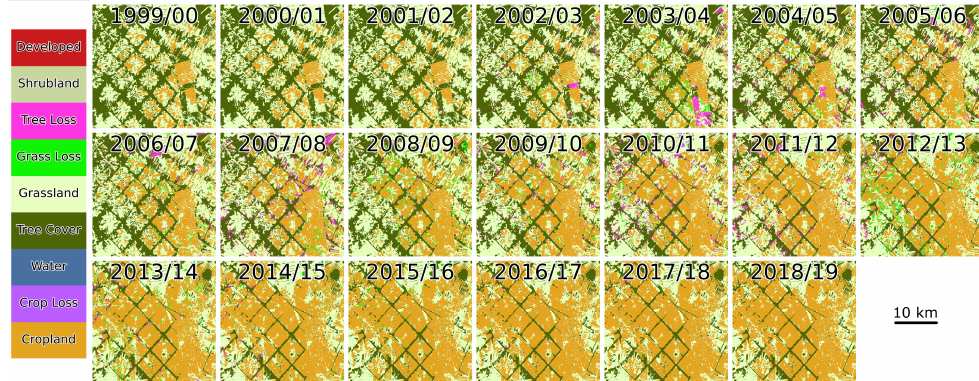
Figure 10. Annual land cover estimates in Santa Cruz province, Bolivia, illustrating expansion of cropland at the expense of herbaceous cover and tree cover loss. The land cover legend is the same as the legend used in Figure 6. However, here we include additional categories to illustrate change: e.g., tree cover loss and herbaceous cover loss from time A to time B.